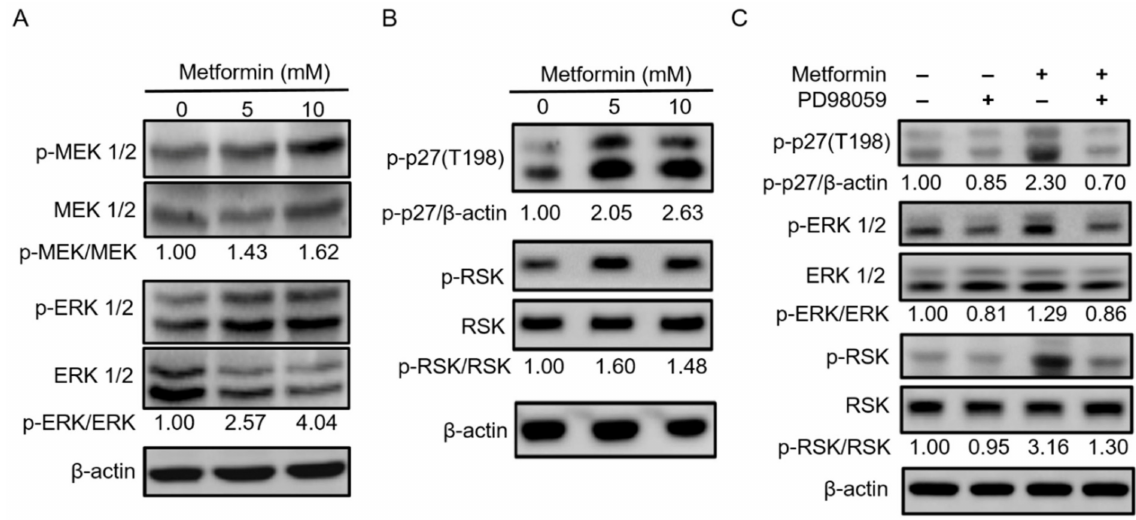
Figure 6. Treatment of hypopharyngeal cancer cells with metformin triggered p27(T198) phosphorylation. ( A , B ) Met- formin induced phosphorylation of MEK1/2, ERK1/2, p27(T198), and downstream RSK. FaDu cells were treated with 0, 5, and 10 mM metformin for 48 h. Cell lysates were analyzed using Western blot assay. ( C ) The MEK/ERK inhibitor (PD98059) decreased phosphorylation of p27(T198) in metformin-treated hypopharyngeal cancer cells. FaDu cells were treated with 5 mM metformin for 48 h. Cell lysates were analyzed by Western blot assay. The relative protein band intensities were quantitated by ImageJ software and normalized by the internal control of β